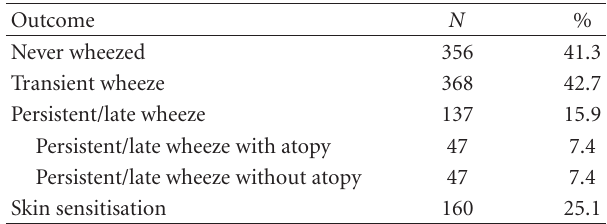
Table 2: Distribution of participants between outcome groups. Outcome